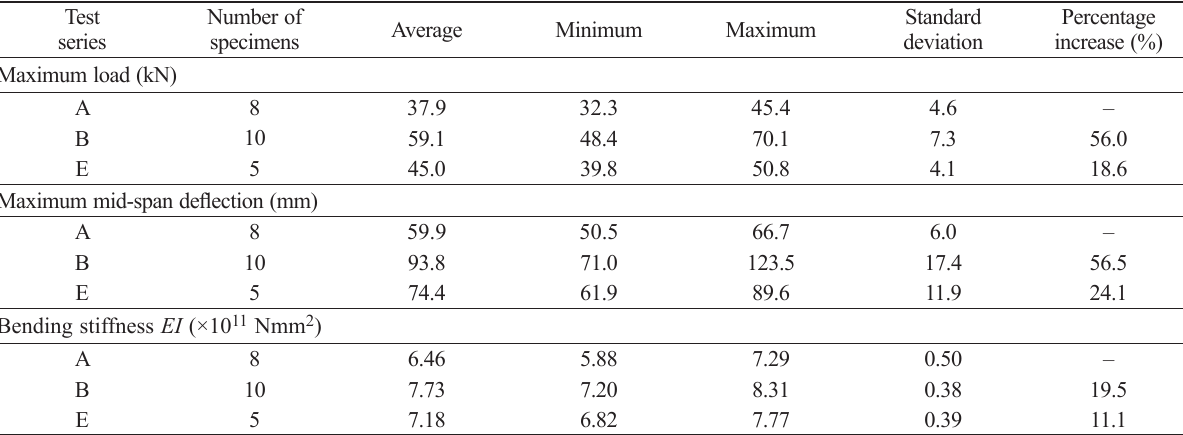
Table 4. Experimental results from bending